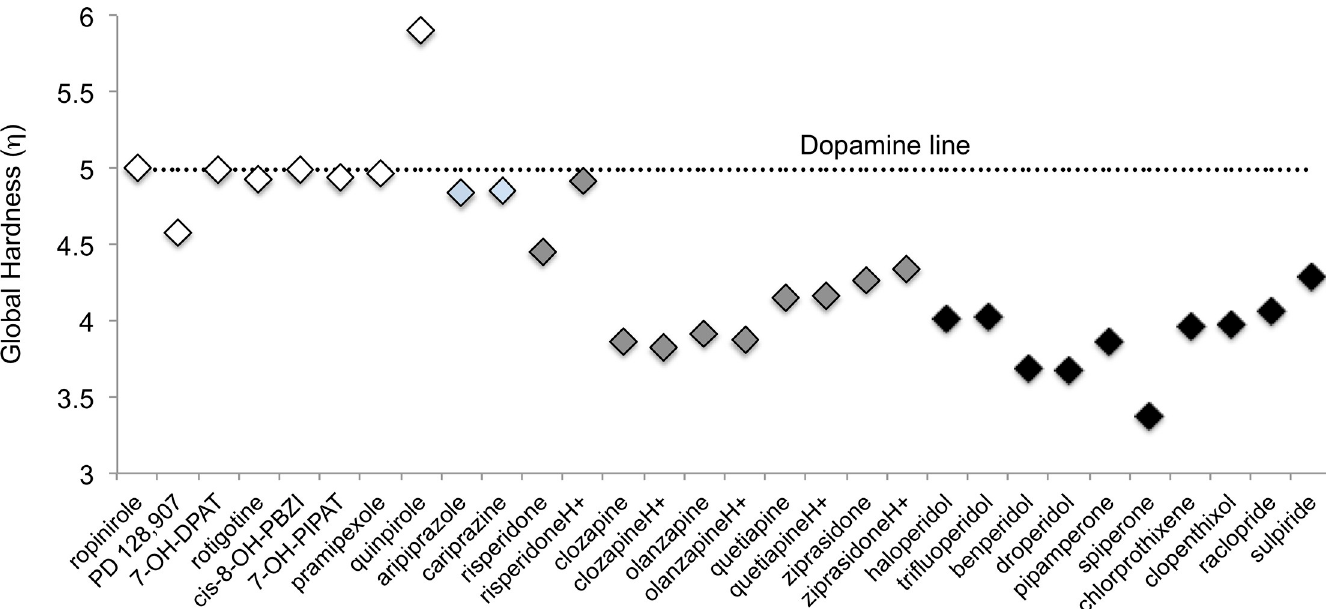
Fig 4. Global hardness ( η ). Global hardness for all the molecules studied in this investigation. FGAs (black rhombus) SGAs (grey rhombus) TGAs (blue rhombus) and agonists (white